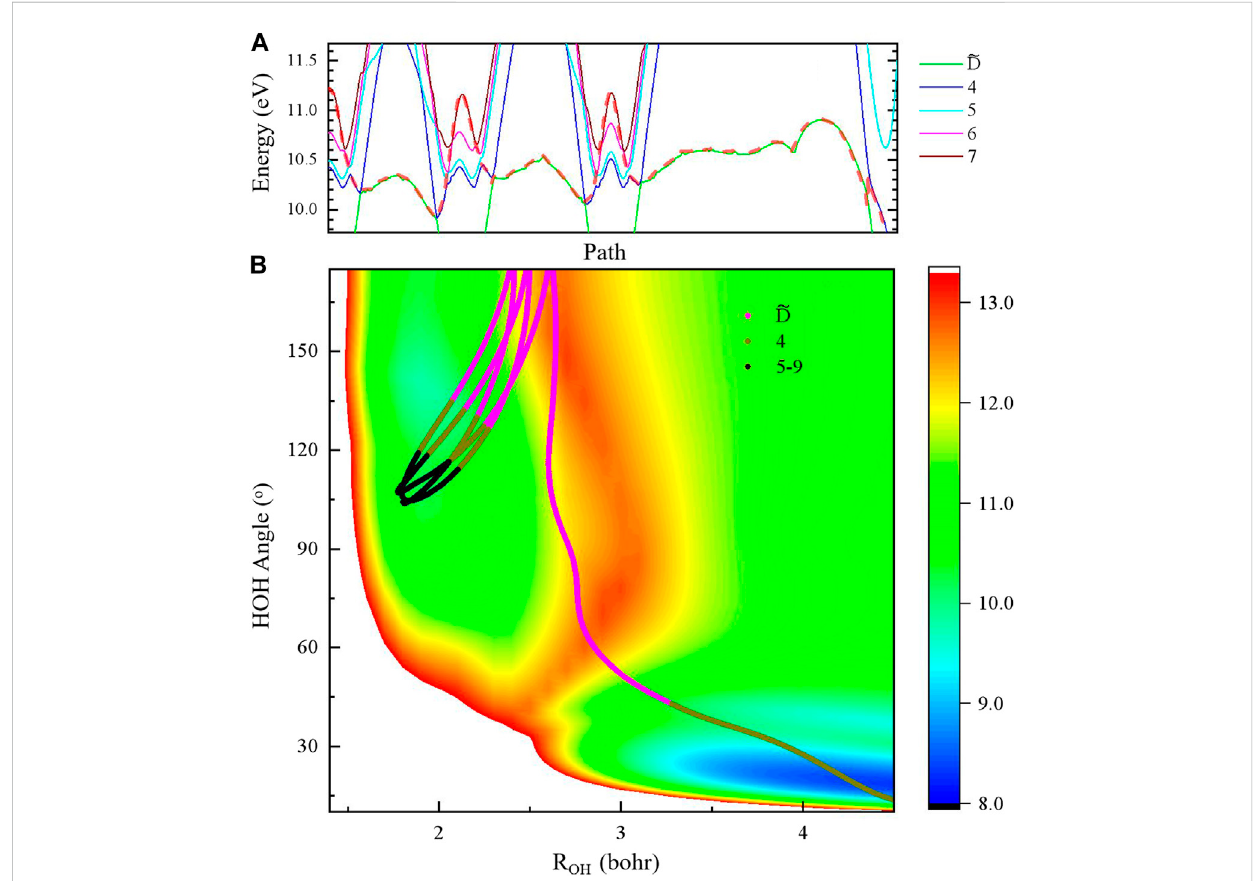
FIGURE 3 Reaction path corresponding to H 2 +O ( 1 S) channel. In panel (A) , the adiabatic potential energies within the 1 A ′ symmetry along the reaction path is shown, the values corresponding to the trajectory is shown as a dashed line. In panel (B) , the symmetric ( R OH1 = R OH2 ) PES of 4 1 A ′ in electron volts is shown, and the trajectory for the H 2 +O ( 1 S) channel is shown in a multi-colored line, and each color correspond to an adiabatic surface shown by the legend. The color of the trajectory line depends on which adiabatic state the system is on during the reaction process. It should be noted that the horizonal axis correspond to the average length of the two OH bonds within this